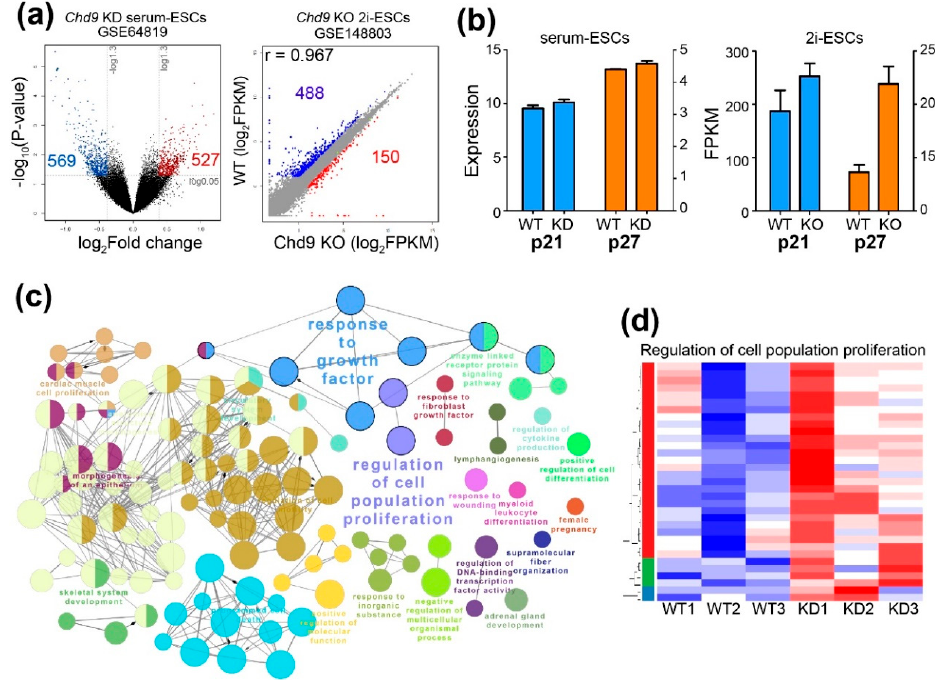
Figure 3. Chd9 depletion alters the expression of genes involved in the cell cycle in the serum-ESCs. ( a ) Volcano and scatter plot of microarray (GSE64819) and RNA-Seq (GSE148803) analyses. Upregulated genes and downregulated genes are indicated as red and blue dots, respectively. ( b ) qPCR analysis of p21 (encoded by Cdkn1a ) and p27 (encoded by Cdkn1b ) in the serum-ESCs and 2i-ESCs. ( c ) Gene ontology (GO) term analysis (biological processes (BP)) in the Chd9 KD serum-ESCs. DEGs that were upregulated upon Chd9 KD were used in the analysis. ( d ) Representative heatmap of the genes significantly altered by Chd9 KD among the genes related to the “regulation of cell population proliferation” category.